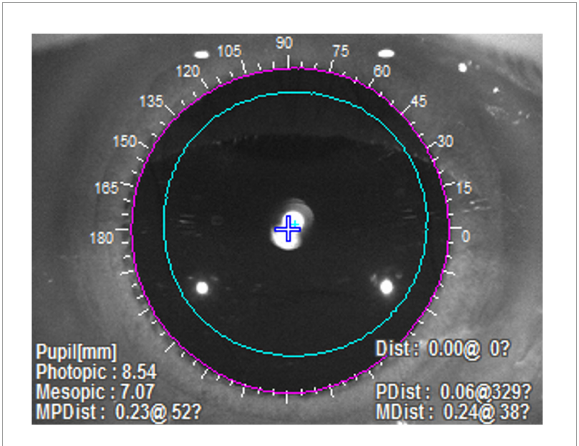
FIGURE1 The measurement of IOL decentration with OPD Scan-III. The purple ring represented the automatically recognized edge of the pupil, and the blue ring, which was manually adjusted, represented the edge of the